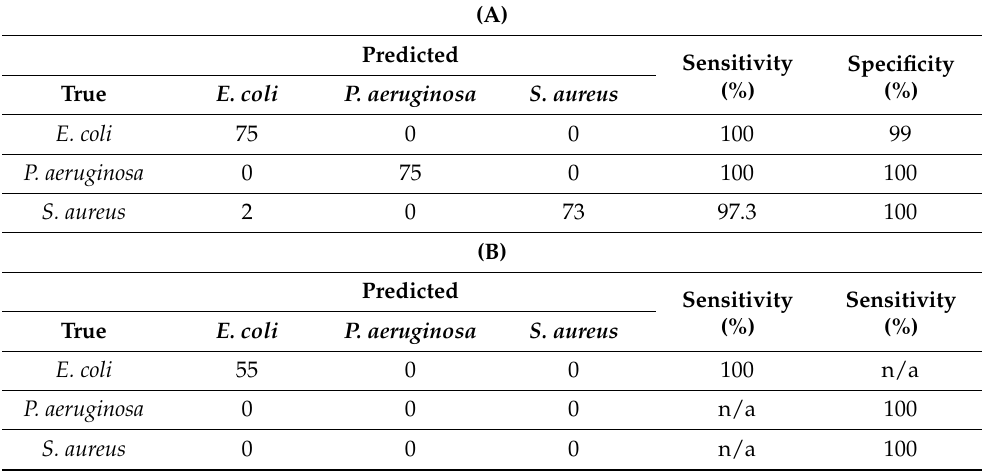
Table 3. ( A ) PCA-LDA results for classification model and ( B ) identification of an independent test data set measured with the mini CCD